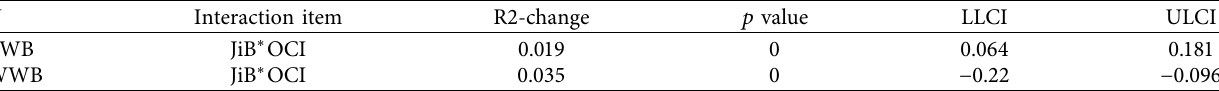
Table 6: Test results of moderating effect ( N � 665).